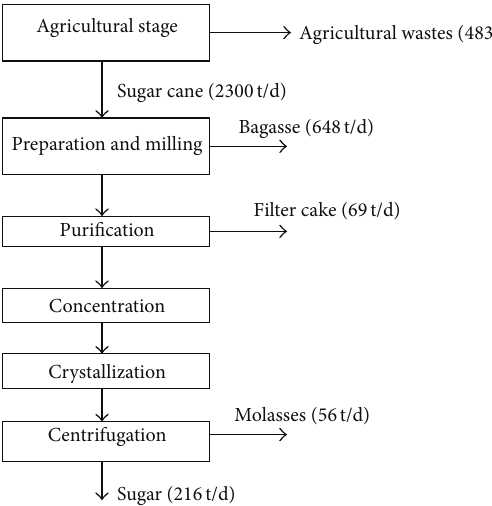
Figure 1: Products and byproducts of the sugar industry.